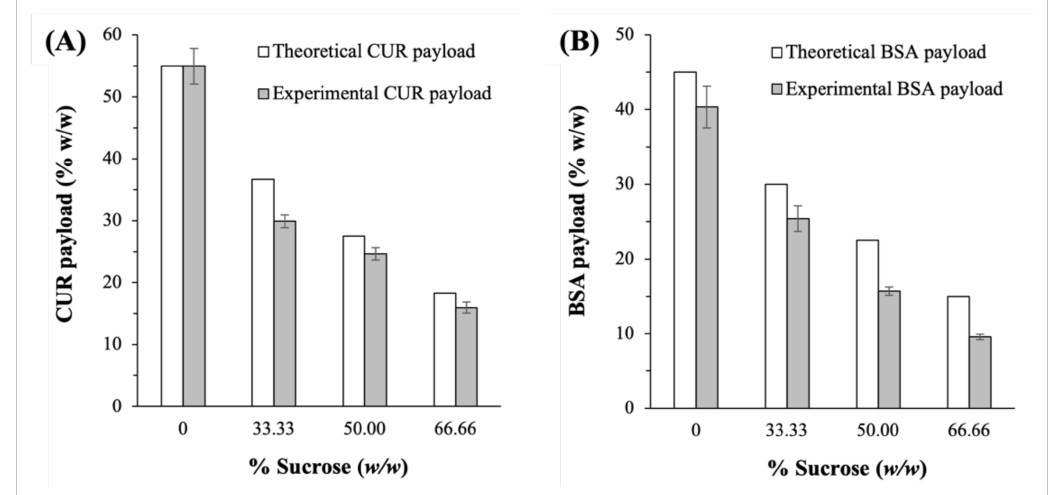
Figure 2. Experimental vs. theoretical payloads of ( A ) CUR and ( B ) BSA in the lyophilized CUR-BSA nanoplexes prepared at different sucrose mass